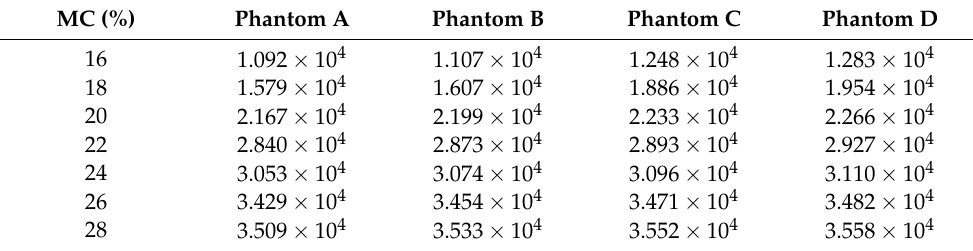
Table 4. Percentage of maximum pixel value using NOSER algorithm.